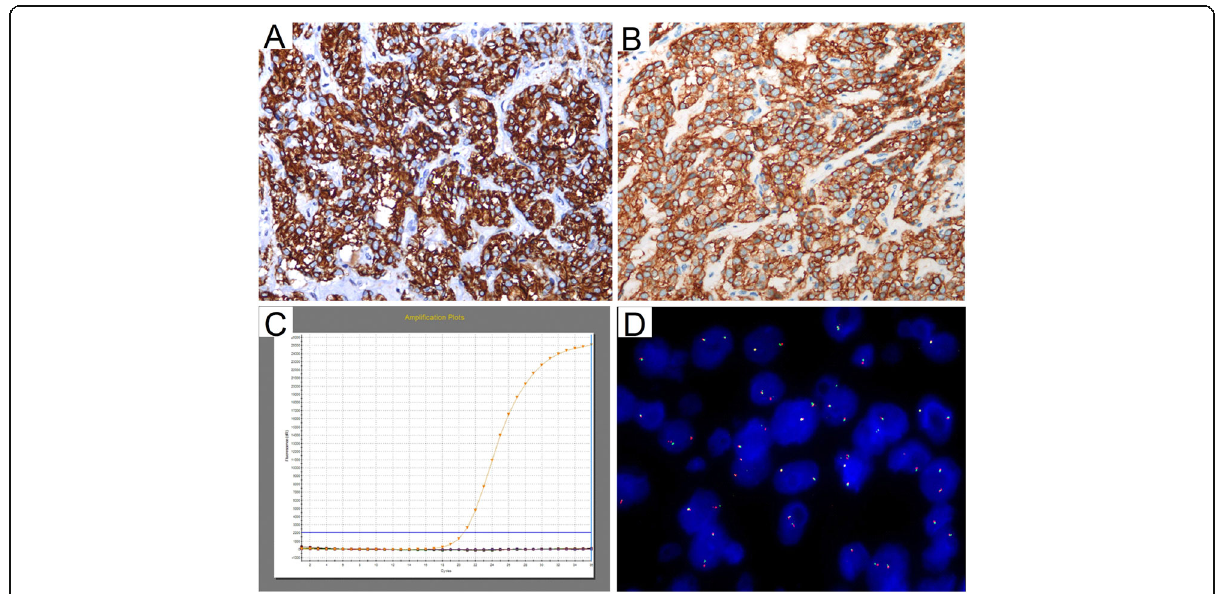
Fig. 3 ALK expression and the ALK genotype in GIST of the current case. Immunohistochemical staining with ALK antibodies demonstrated diffuse ALK expression within epithelioid tumor cells. Staining results for the D5F3 clone ( a , IHC, 200×) and 1A4 clone ( b , IHC, 200×) are displayed. No fusion of ALK was detected by ARMS-PCR ( c ). A break-apart fluorescent in situ hybridization (FISH) assay did not find ALK rearrangement ( d ,